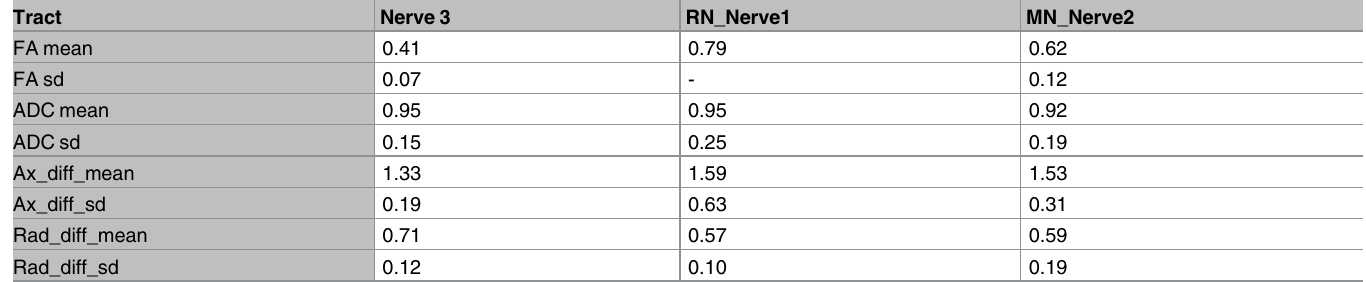
Table 4. Quantitative DTI track analysis values for forearm nerves as shown in Fig 7, [FA: Fiber Anisotropy, ADC: Apparent diffusion coefficient, Ax: Axial/Longitudinal, Diff: Diffusivity, sd: standard deviation, and Rad: Radial]. Tract